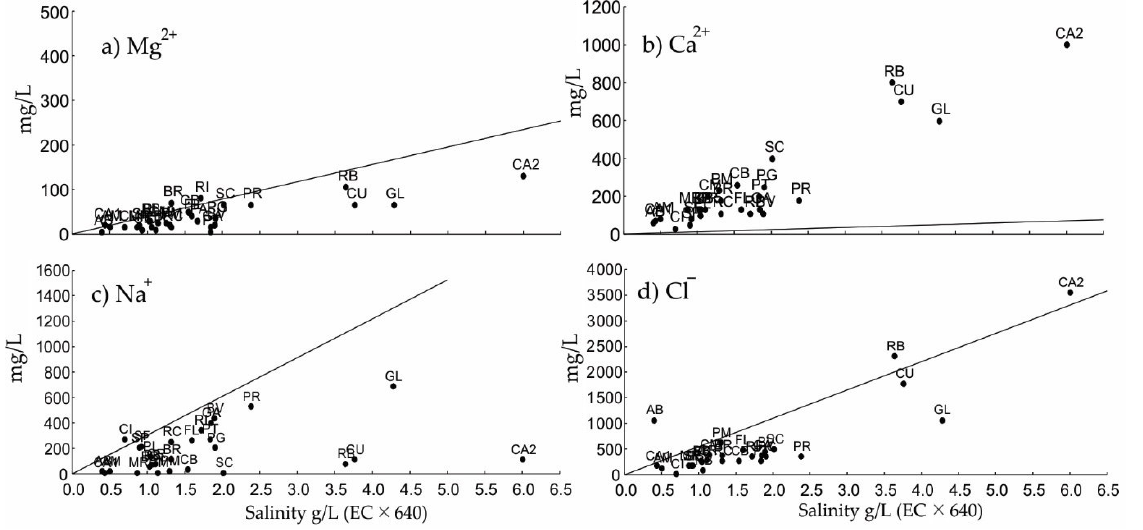
Figure 7. Concentrations (mg/L) of ( a ) Mg +2 , ( b ) Ca +2 , ( c ) Na + , and ( d ) Cl − versus salinity in groundwater obtained by multiply EC by 640. The solid lines represent the concentrations of the respective ion in normal seawater diluted to different salinities.